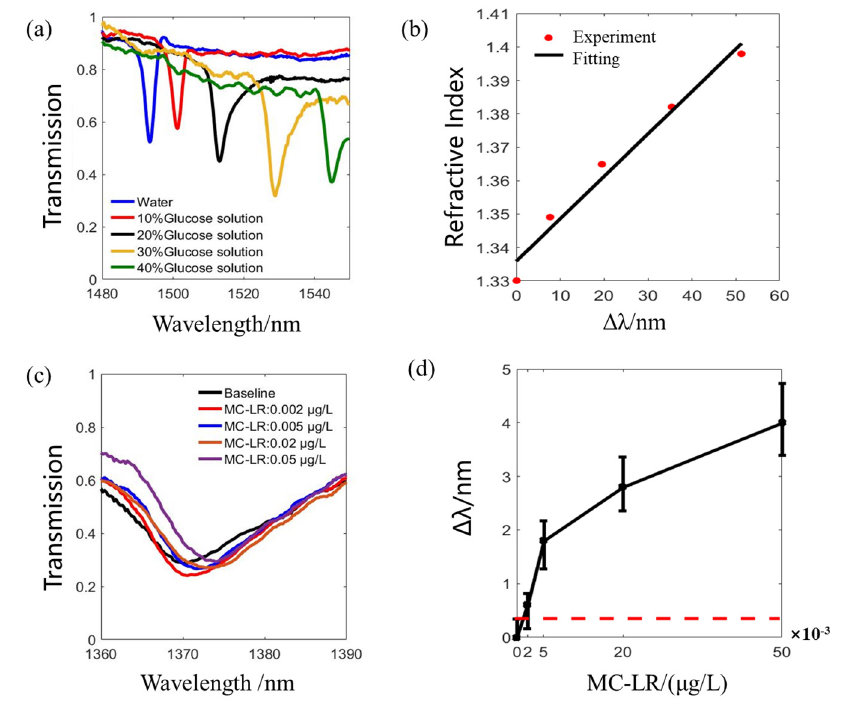
Figure 3. Refractive index sensitivity detection and MC-LR detection. ( a ) The transmission spectrum under different background refractive indices, where the different background refractive indices are obtained by water and different concentrations of glucose solutions. ( b ) The relationship between the environmental refractive index and the offset of the resonant wavelength. ( c ) Transmission spectrum with different MC-LR concentrations. ( d ) The relationship between the MC-LR concentrations and the offset of the resonant wavelength. The red dotted line marks the wavelength shift caused by the environment.